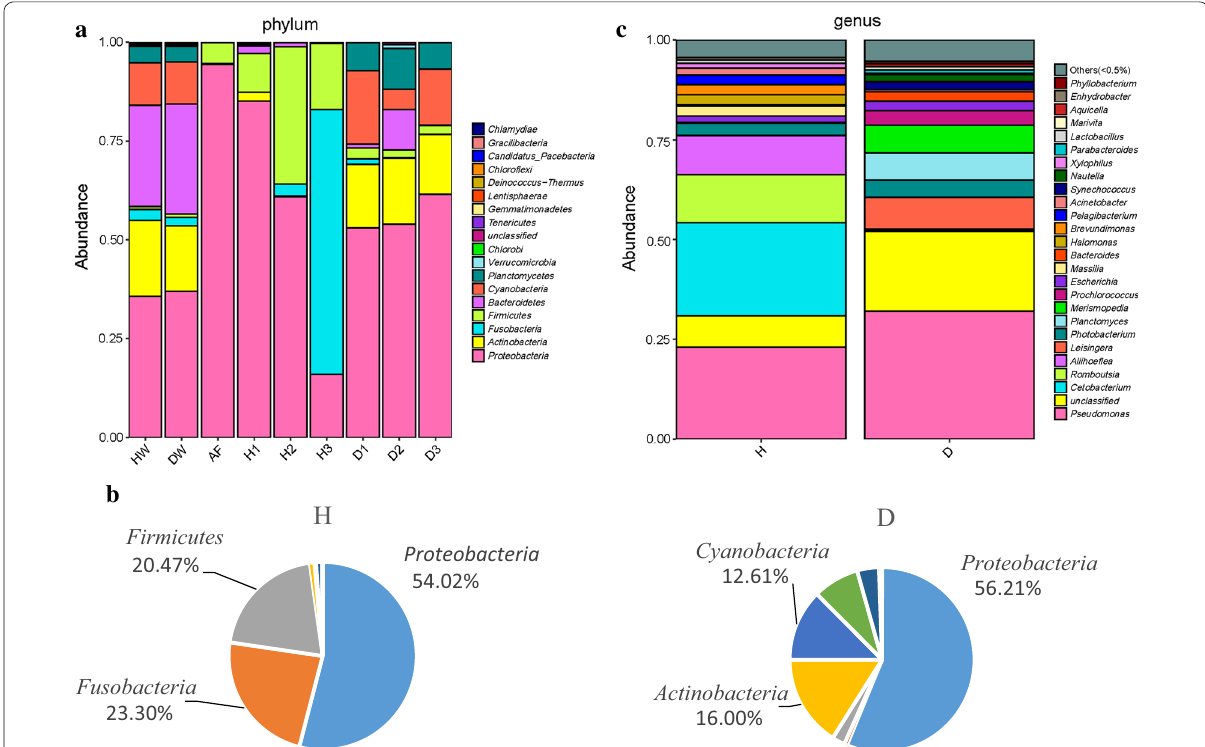
Fig. 2 a Relative abundance of each sample at the taxonomic level of phylum. b Comparison of the relative abundances of the dominant intestinal microbiota phyla between the healthy and diseased Yunlong Grouper. c Relative abundance of the dominant genera (mean relative abundance > 0.5%) in the intestinal microbiota between the healthy and the diseased Yunlong